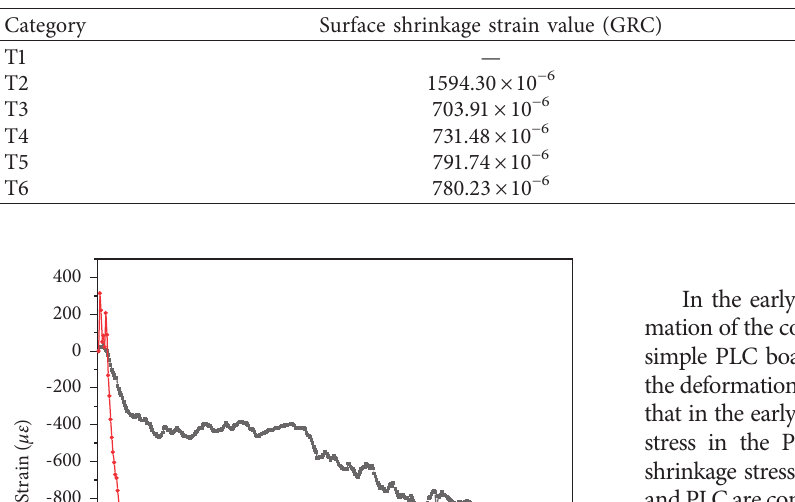
Table 6: Maximum shrinkage strain values of various specimens.